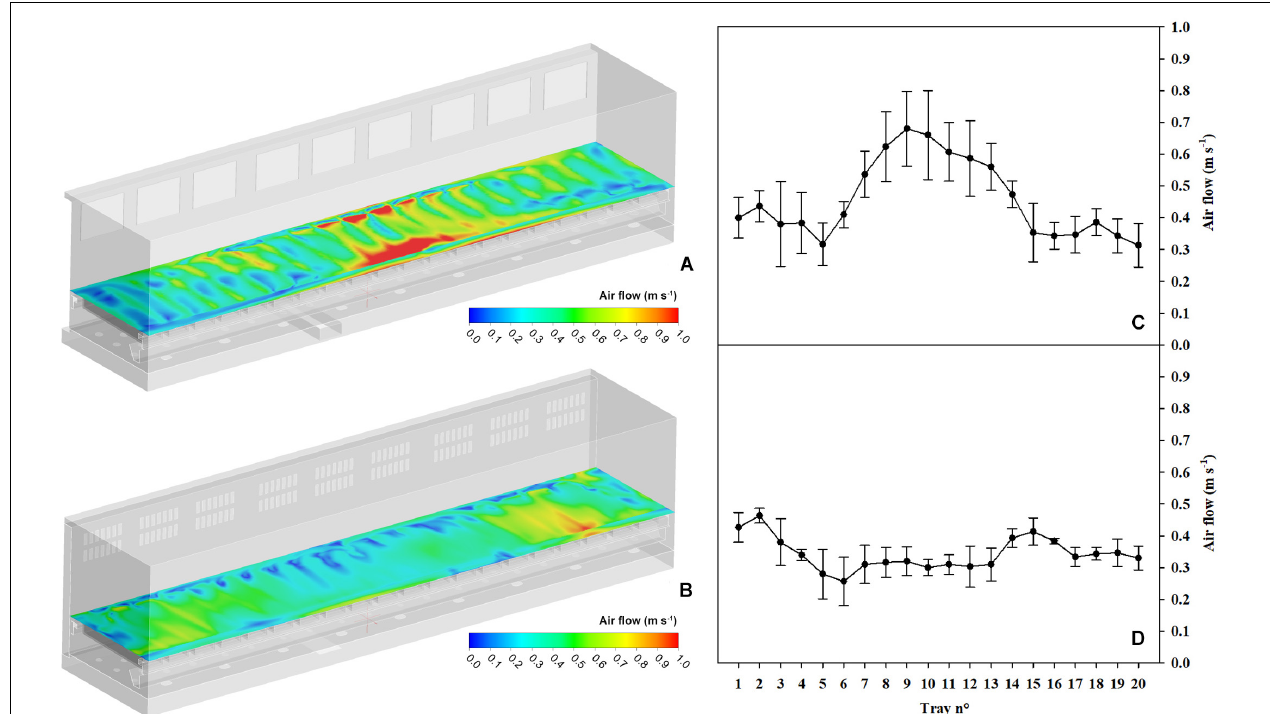
FIGURE 3 | Computational Fluid Dynamics (CFD) analysis of the airspeed at the canopy level along the Higher Plant Chamber (HPC) surface and average airspeed at the canopy level per tray in Test 1 ( A,C , respectively) and Test 2 ( B,D , respectively).